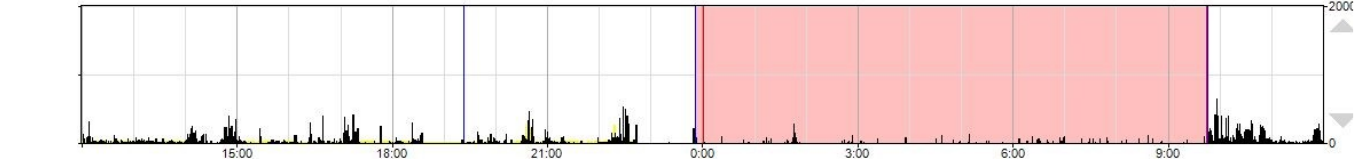
Figure 1. An example of an adults actigraph data of 24 h . The red area marks sleep.